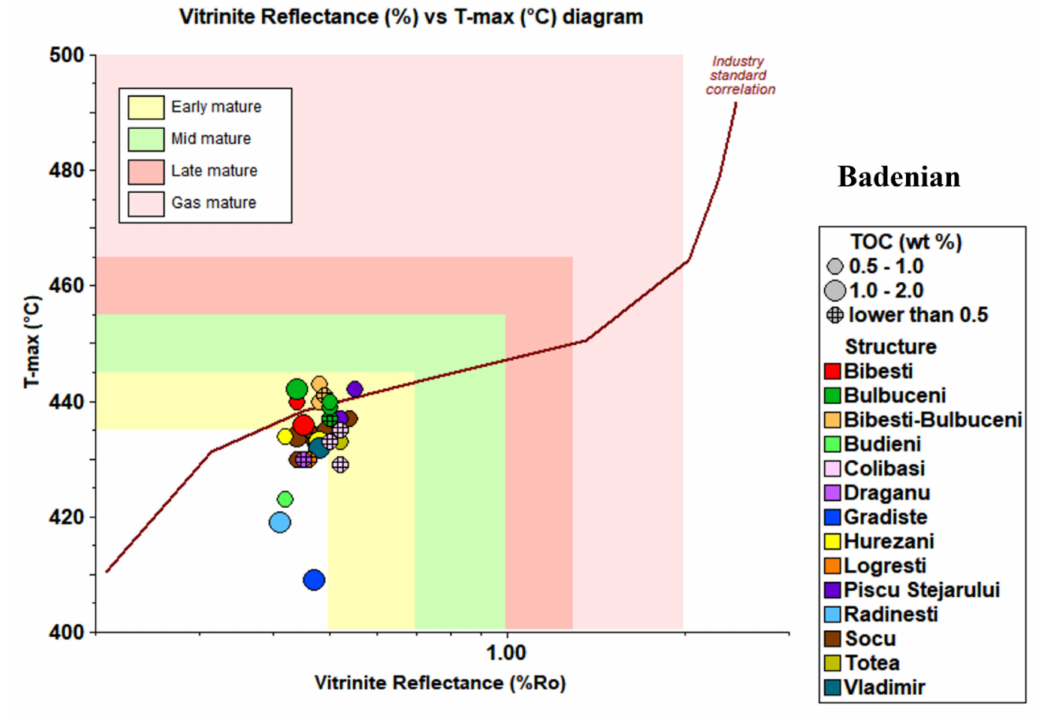
Figure 9. Vitrinite reflectance VR o (%) vs. T max ( ◦ C), showing the thermal maturity of the Upper Badenian source rocks from the central-southern part of the Getic